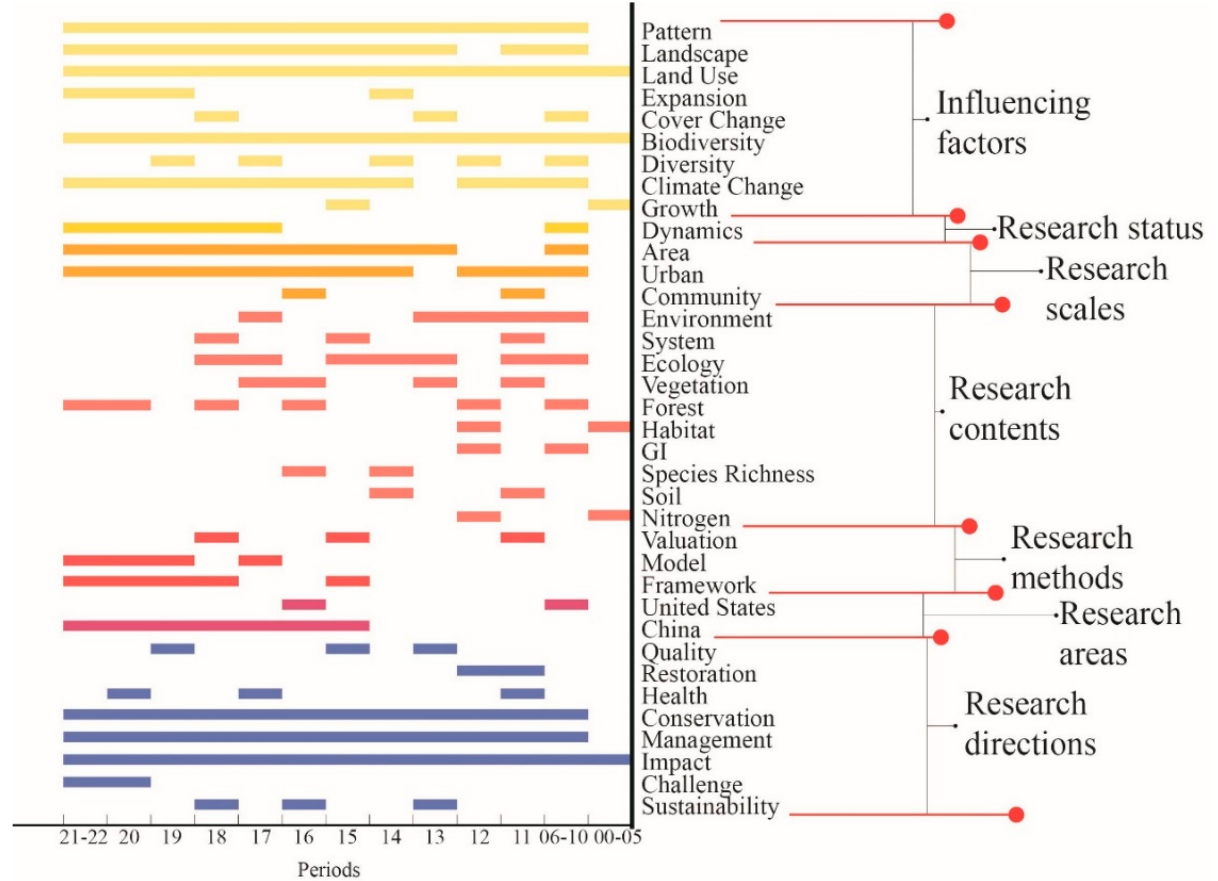
Figure 3. Changes in study trends.